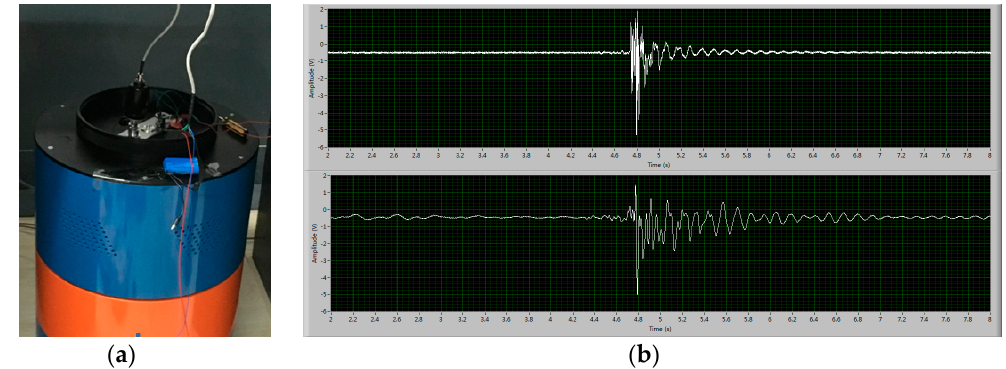
Figure 7. Experimental environment of the vibration table and the data acquired from NI PXI (a product of National Instrument Corporation).